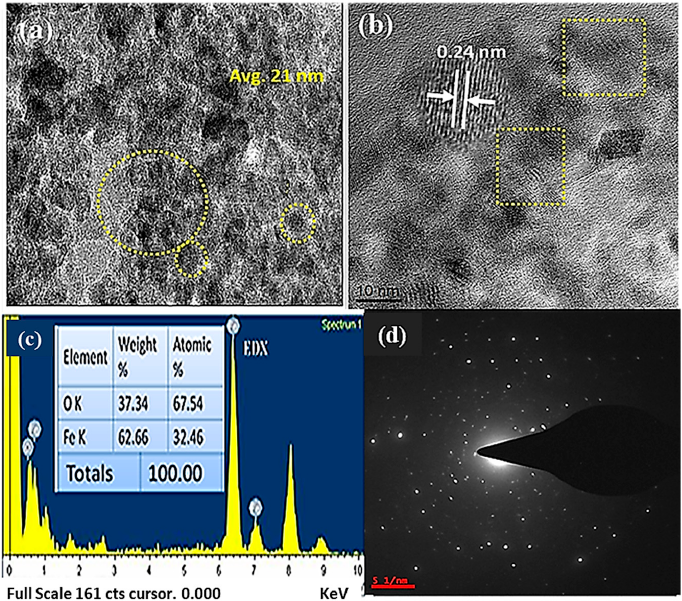
Figure 4. ( a ) Shape and size for IONPs by TEM. ( b ) HRTEM image for F3O4 NPs, ( c ) EDX spectra. ( d ) The SAED pattern of IONPs.